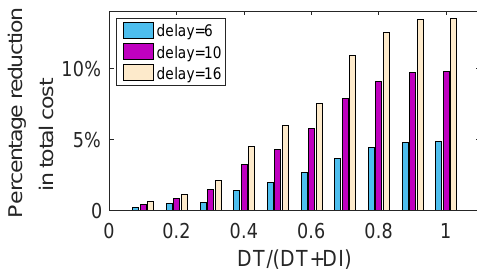
Figure 7. Reduction in cost versus DT ratio.